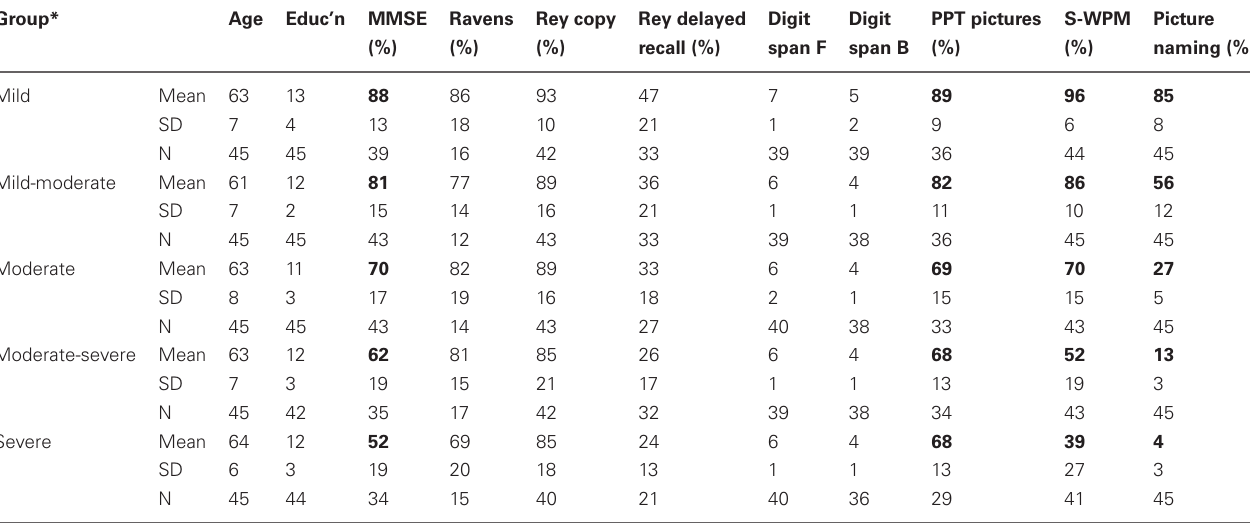
Table 1 | Demographic information and neuropsychological test scores associated with each of the 225 observations of picture naming data from semantic dementia patients included in the present study, grouped according to level of severity (Reproduced from Table 1 of Woollams et al. (2008,